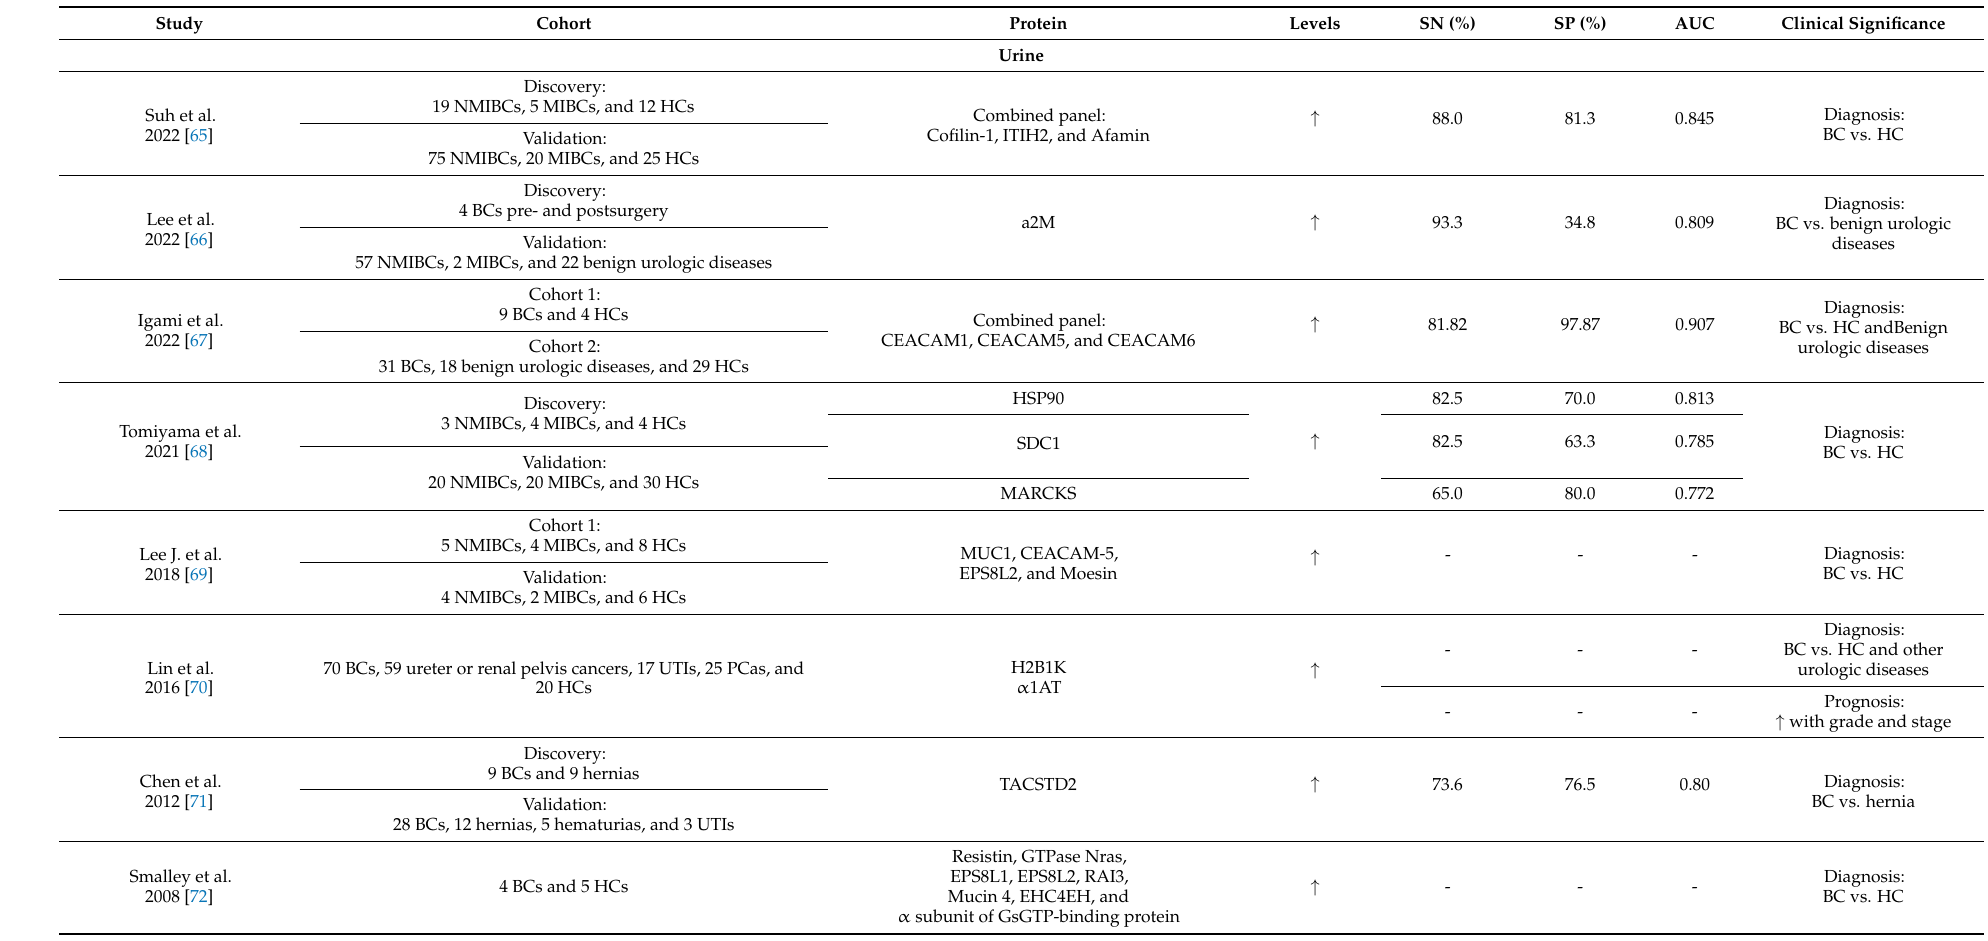
Table 3. Proteins with potential in the management of bladder cancer